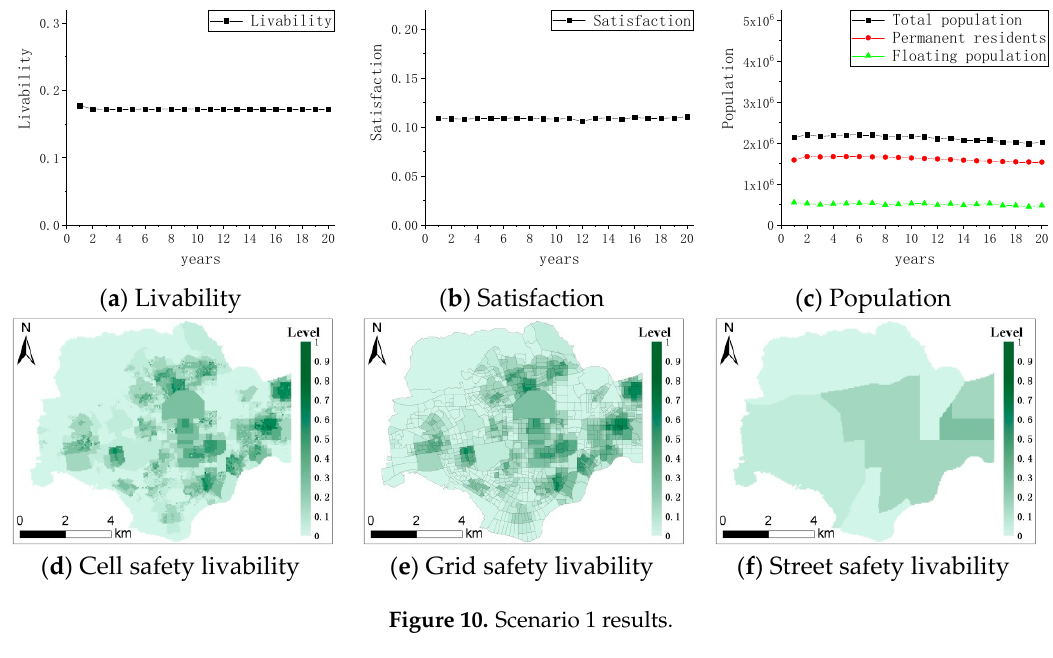
Figure 10. Scenario 1 results.